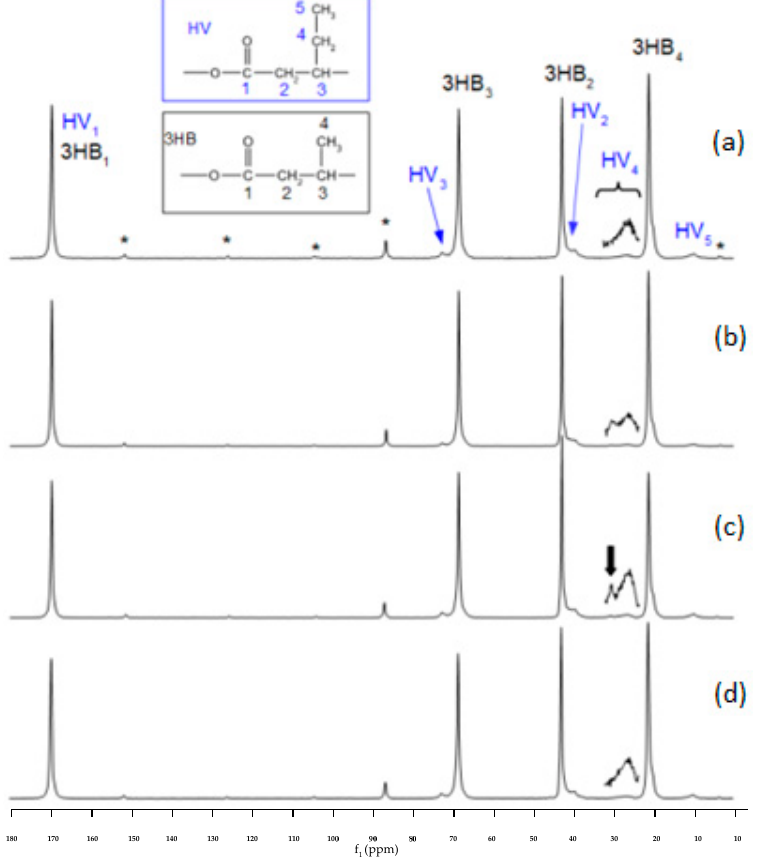
Figure 8. 13 C CPMAS NMR spectra of samples produced from different carbon and nitrogen sources: ( a ) real volatile fatty acid (VFA) stream, ( b ) glucose/(NH 4 ) 2 SO 4 , ( c ) VFA/urea, ( d ) VFA/(NH 4 ) 2 SO 4 using a contact time of 2 ms. * indicates peaks due to spinning